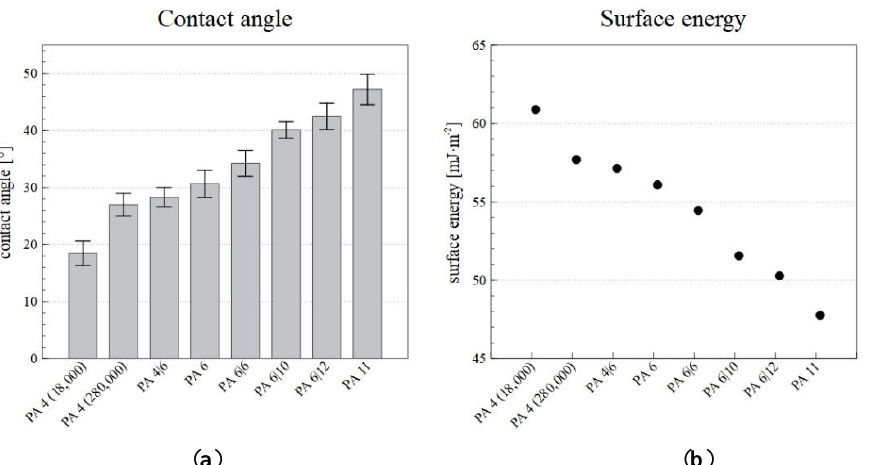
Figure 7. The contact angles ( a ) and surface energies ( b ) of the PA nanofiber layers produced via the Nanospider TM device.